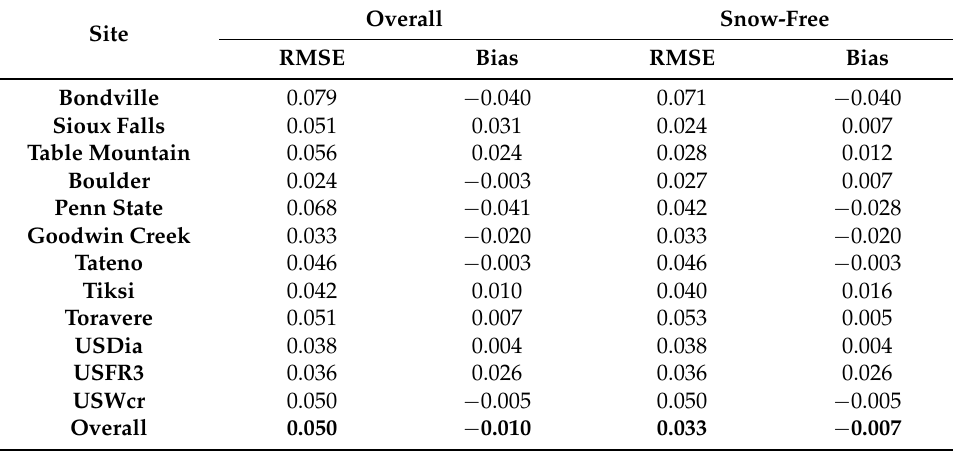
Table 2. Summary of ground validation results over 12 vegetated sites. Generic BRDF LUT is used to retrieve LSA over these sites. “Overall” displays the statistics by including all available observations, while “Snow-free” only considers those snow-free observations whose ground albedo measurements are below